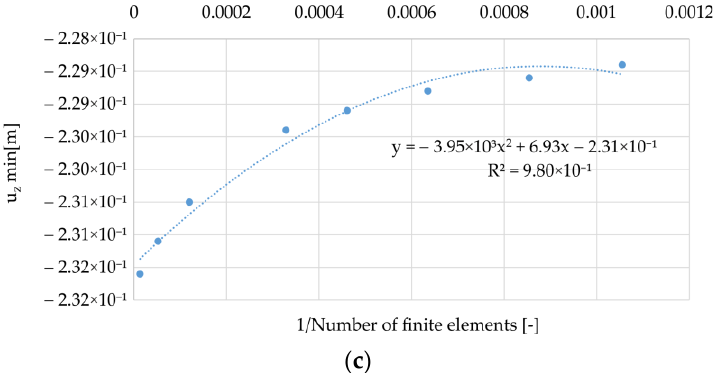
Figure 7. ( a ) Strain in the middle between columns; ( b ) Mises stresses, ( c ) u z min, as a function of 1/N—approximation.